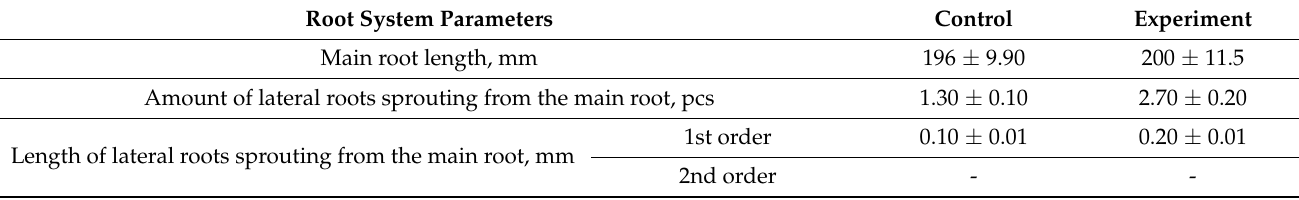
Figure 9. The root system of S. tau-saghyz seedlings (( 1 ): control; ( 2 ): experiment).